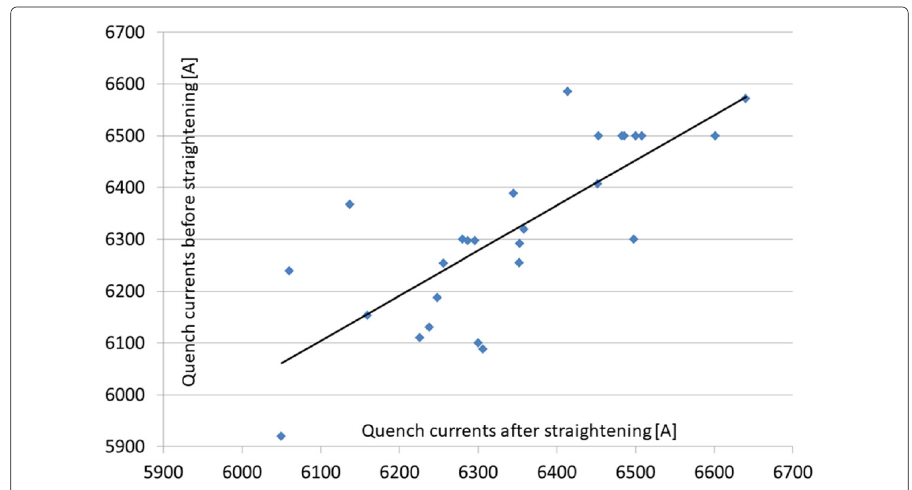
Fig. 23 Quench currents of dipoles before straightening vs. after straightening